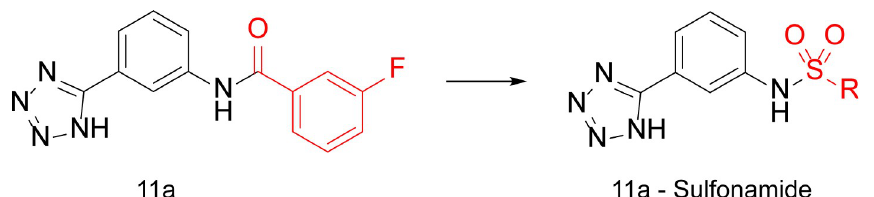
Fig 11. Design strategy for amide derivatives. Virtual Screening hit 11a (left), amine 1 (black) and the optimized part of the molecule (red).